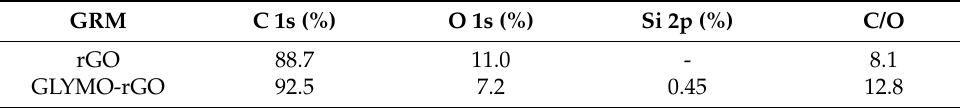
Table 2. Results obtained by XPS spectroscopy for